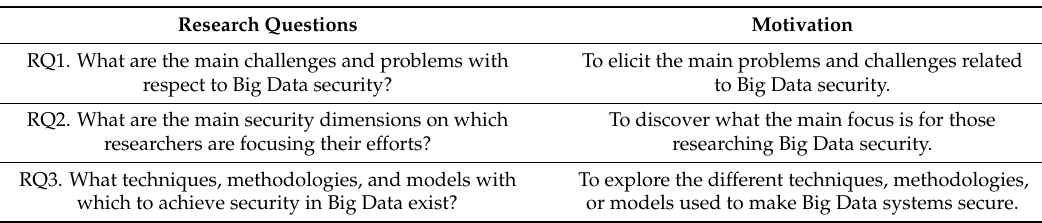
Table 1. Research questions and their